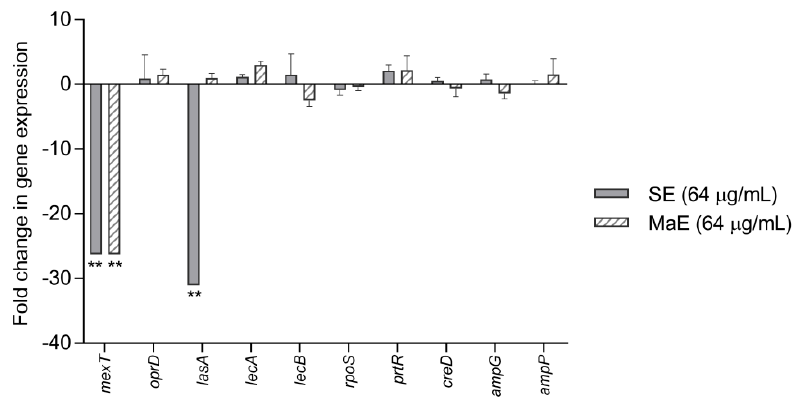
Figure 4. Effect of P. americana seed ethanol extracts on expression of virulence-related genes in Pseudomonas aeruginosa ATCC 27853. SE: ethanol extract obtained by Soxhlet; MaE: ethanol extract obtained by maceration. The mRNA expression levels of genes were calculated through the value obtained between the Δ Ct values of treated and untreated bacteria (Control). creB gene was used as internal control. All results are expressed as mean ± SD. (**) Significant differences at the 1 % level according to one-way ANOVA test followed by the Tukey´s test ( n = 4).